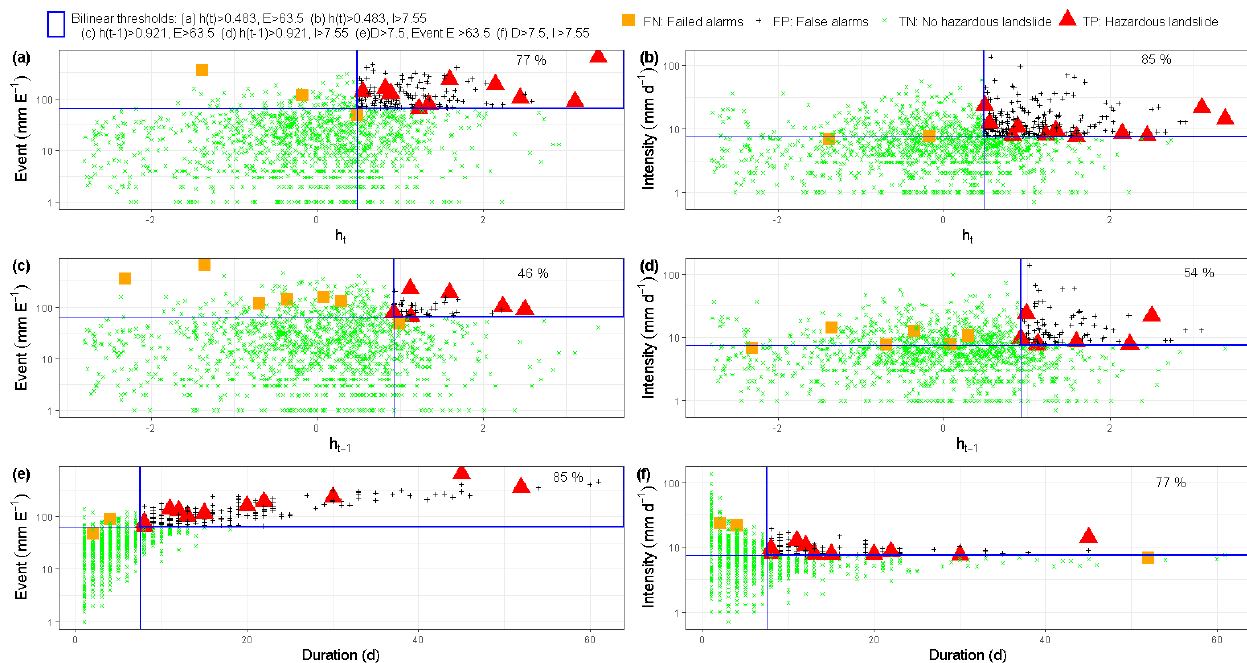
Figure 9. Landslide warning capabilities of the hydro-meteorological and precipitation threshold: (a) h t – E , (b) h t – I , (c) h t − 1 – E , (d) h t – E , (e) E – D , and (f) I – D in Mukungwa catchment.